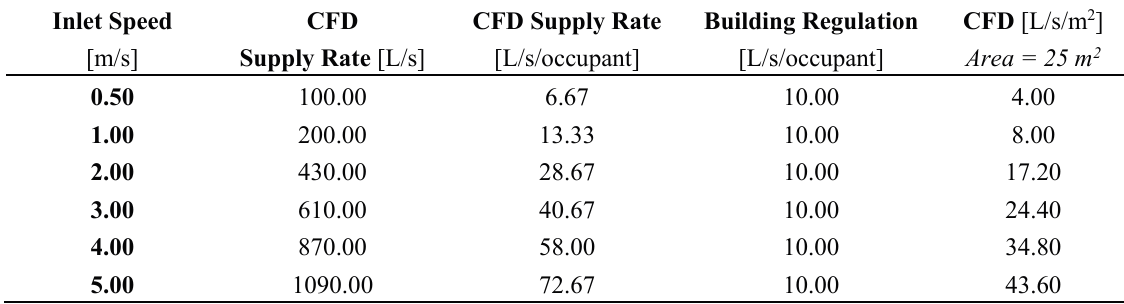
Table 2. Summary of the supply rates of the wind tower without heat transfer